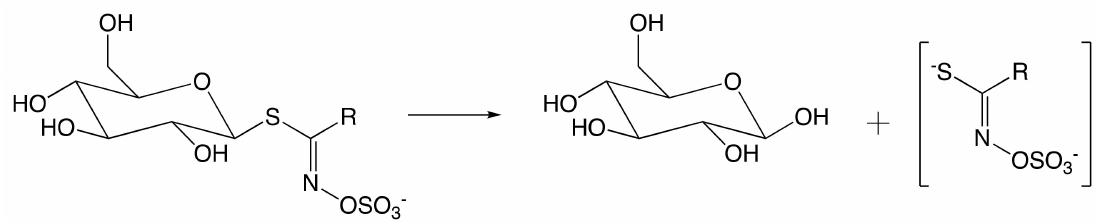
Figure 1. Hydrolysis of glucosinolate (GSL) by myrosinase (MYR) upon tissue disruption. (R = alkyl, aryl,